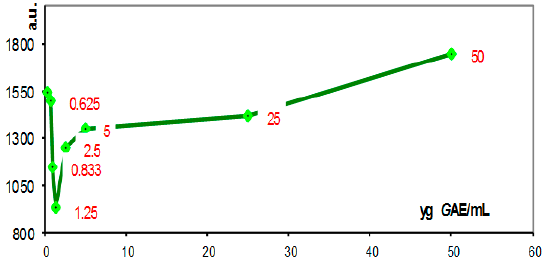
Figure 2. IC 50 assay on chokeberry leaves. Hot-assisted ethanolic